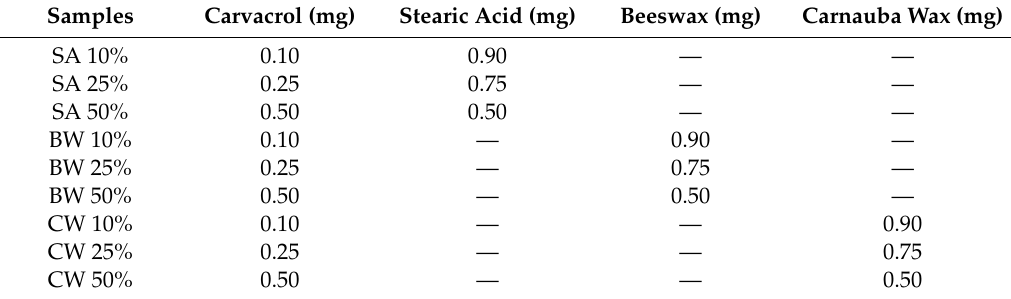
Table 1. Composition of the binary mixtures (%, m /